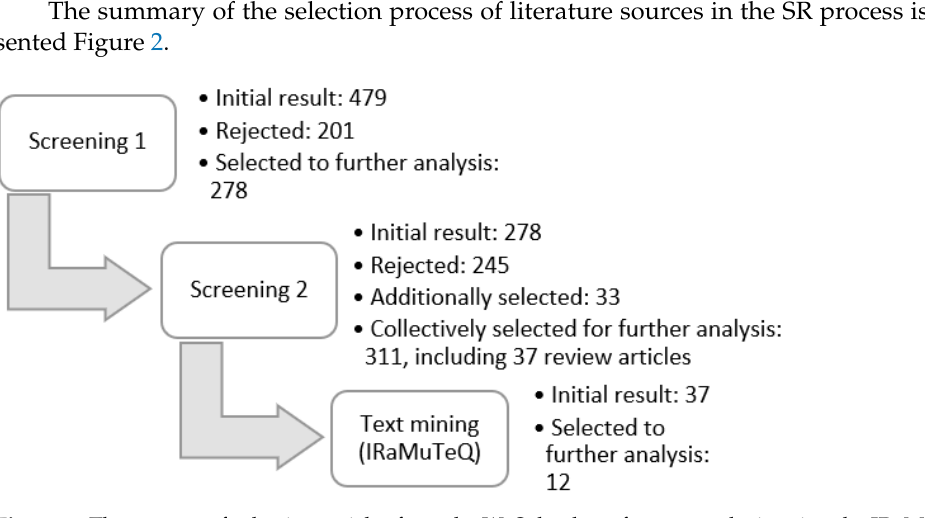
Figure 2. The process of selecting articles from the WoS database for text analysis using the IRaMuTeQ software. Source: own elaboration.